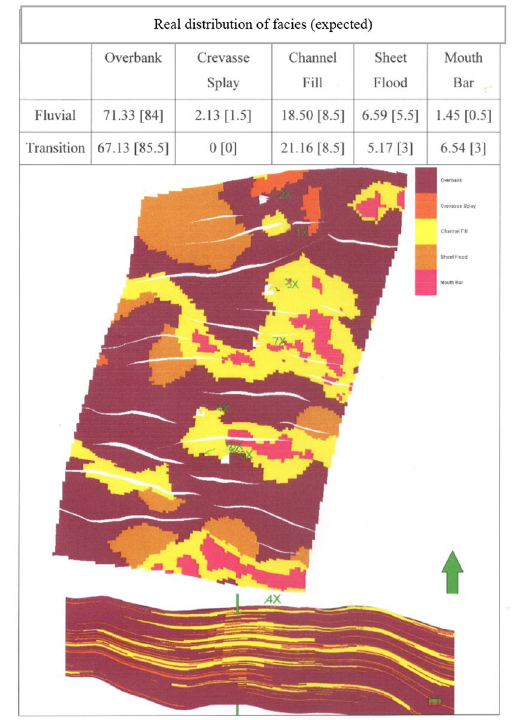
Fig. 26 Resulting model of case R1_3